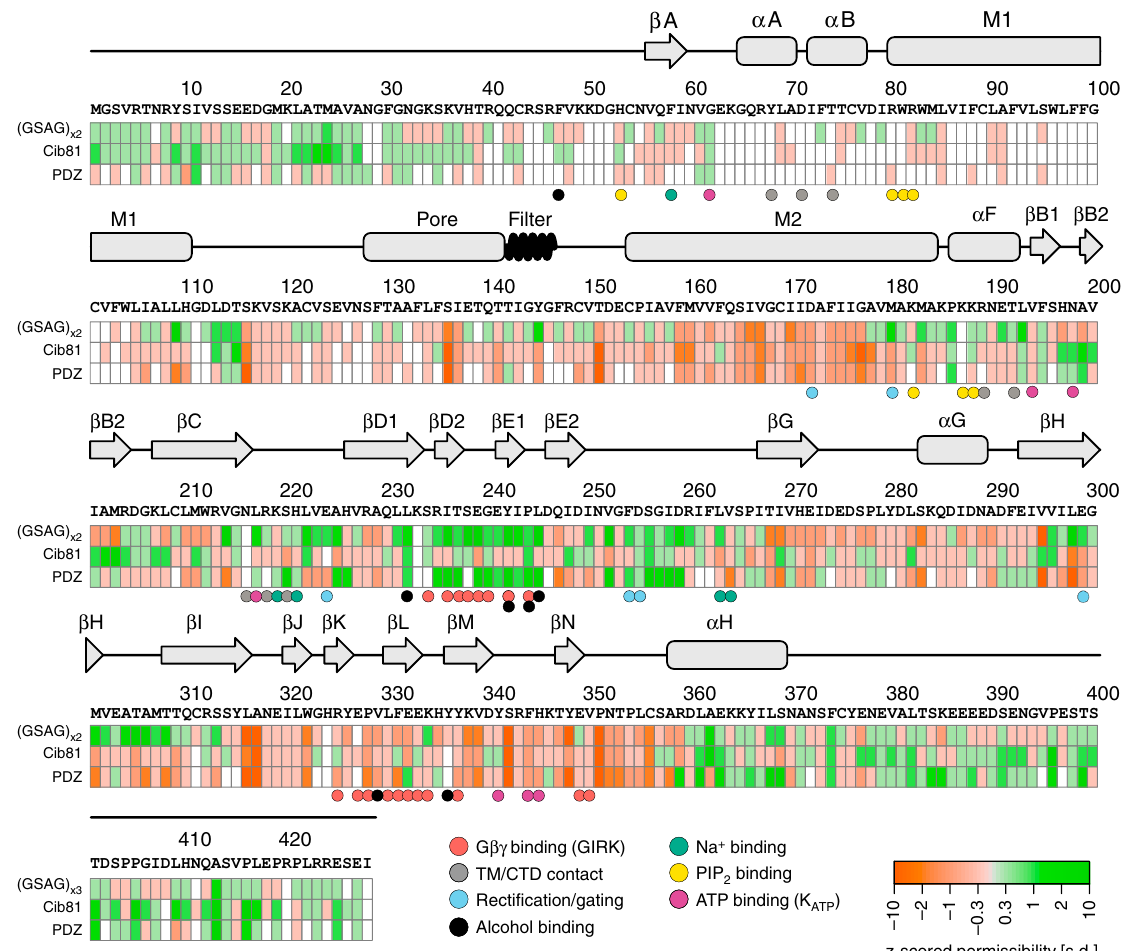
Fig. 2 Domain insertion permissibility in hKir2.1. The primary sequence of human Kir2.1 (GI: 4504835) and secondary-structure elements are shown along with the permissibility score for three types of inserted domains (indicated on the left). Residues colored white refer to those for which there was insuf fi cient data to assign a permissibility score. Key residues with functional relevance in Kir2.1 or a homolog (GIRK, K ATP ) are indicated by